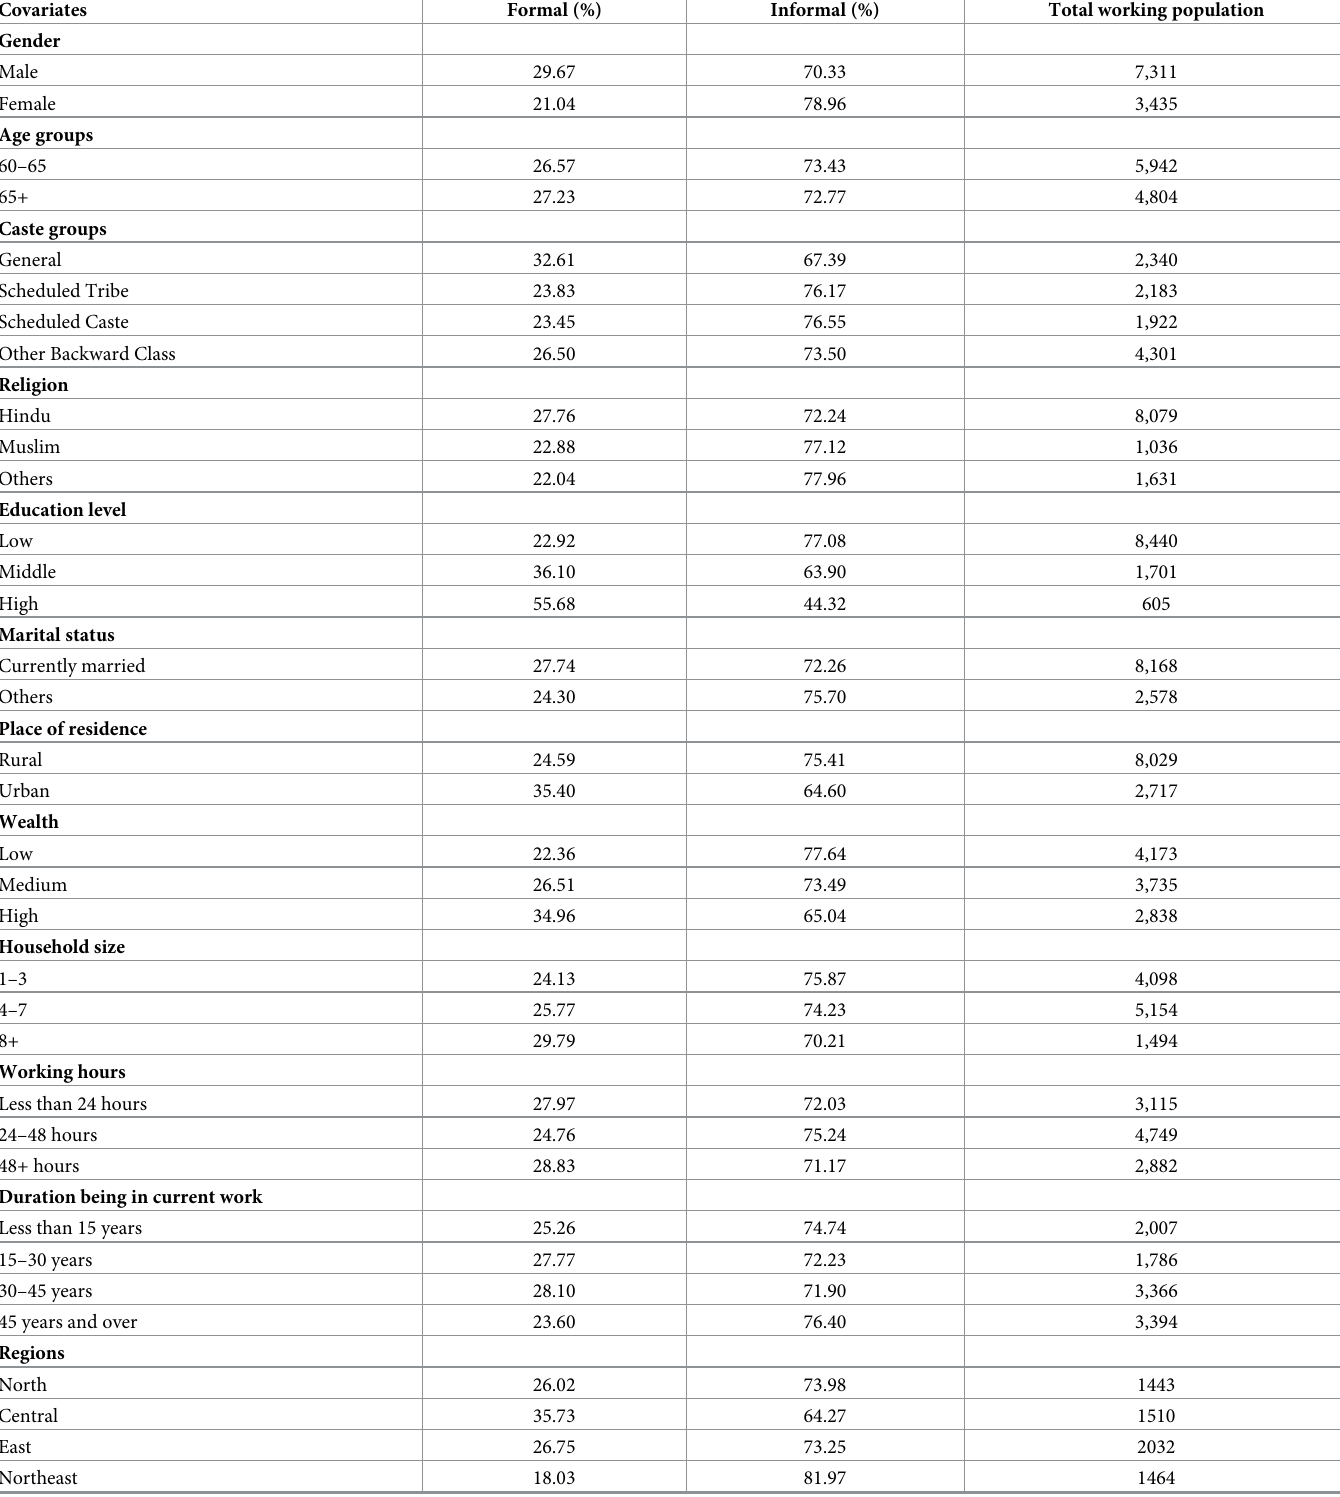
Table 3. Type of work by socio-economic and demographic characteristics.